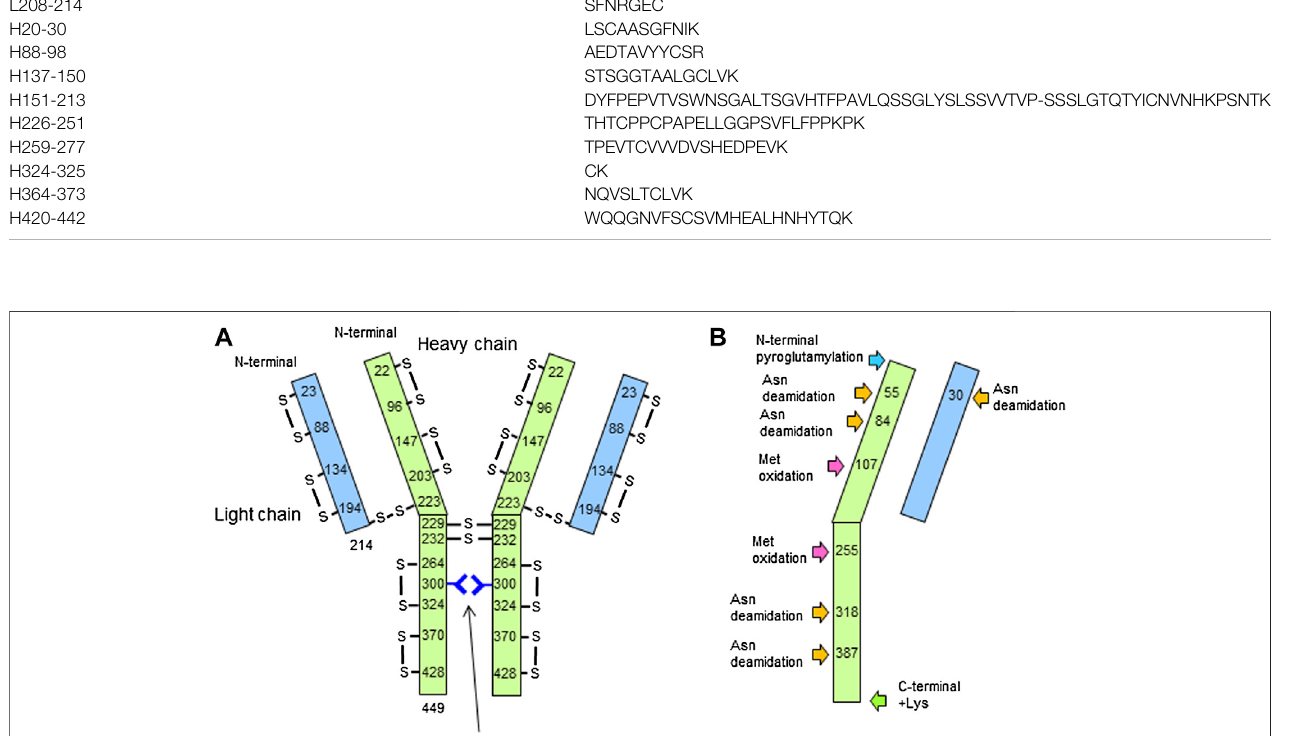
Frontiers in Molecular Biosciences |